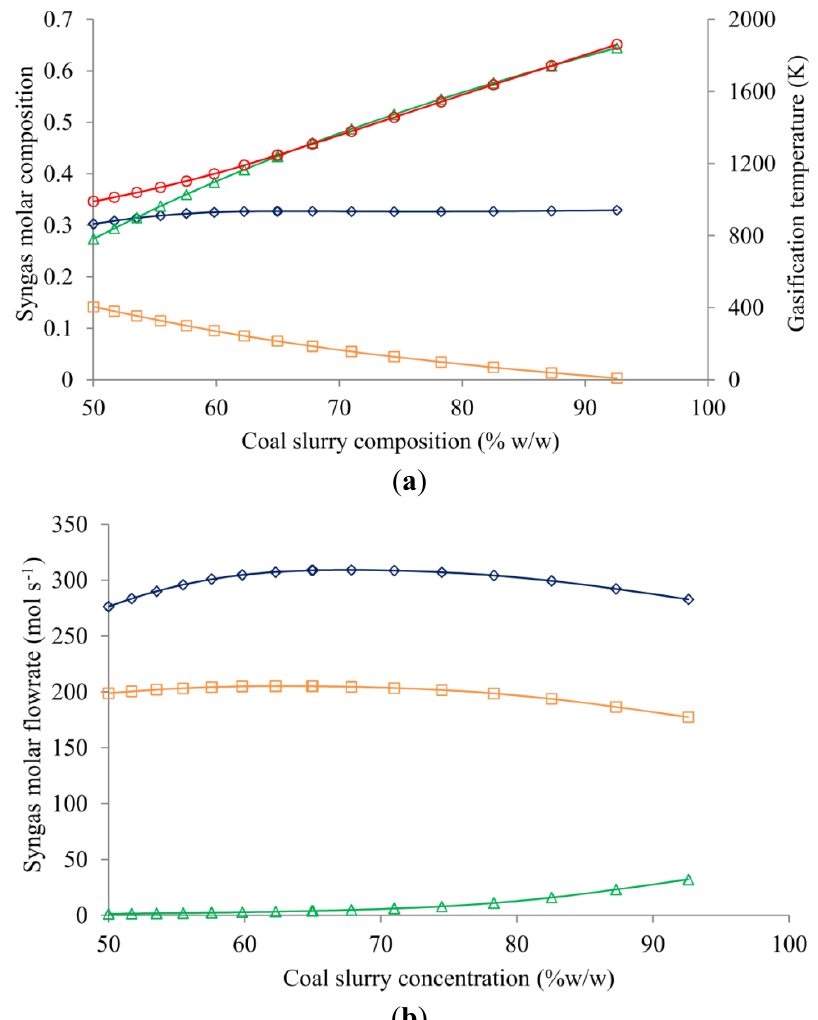
Figure 2. Effect of the coal slurry concentration on ( a ) the syngas composition upstream WGS reactor and ( b ) molar flow rate downstream the WGS reactors: CO ( ∆ ), H ( □ ) and the adiabatic temperature ( ○ ) with O LTS reactor operating temperature: 473 K and HTS reactor operating temperature: 623 K as fixed